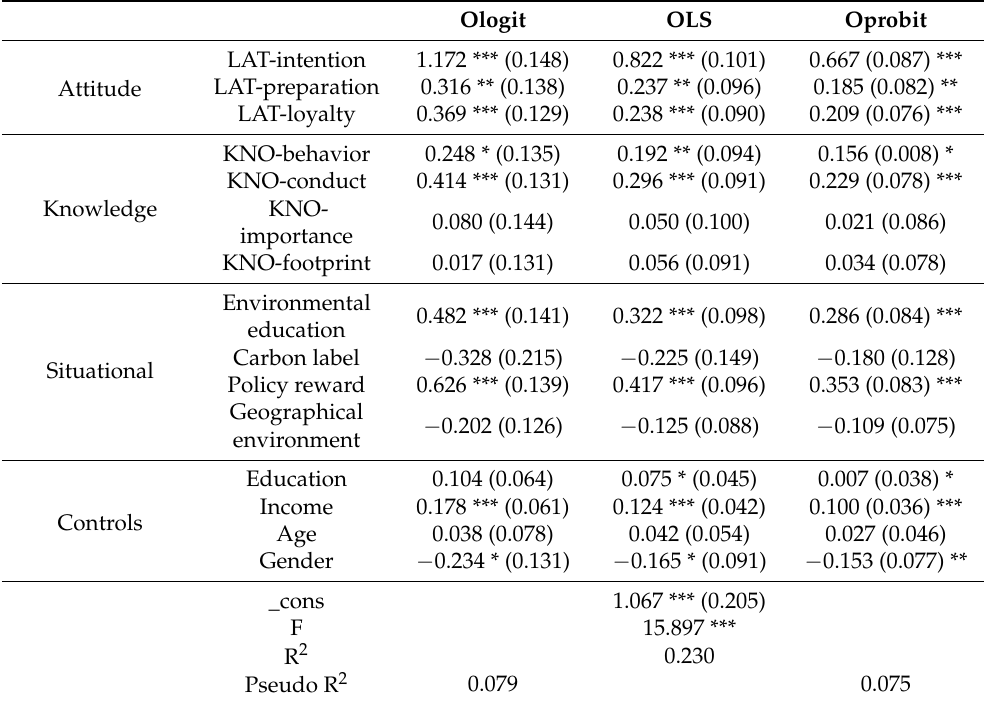
Table 6. Factors that influence tourists’ low-carbon